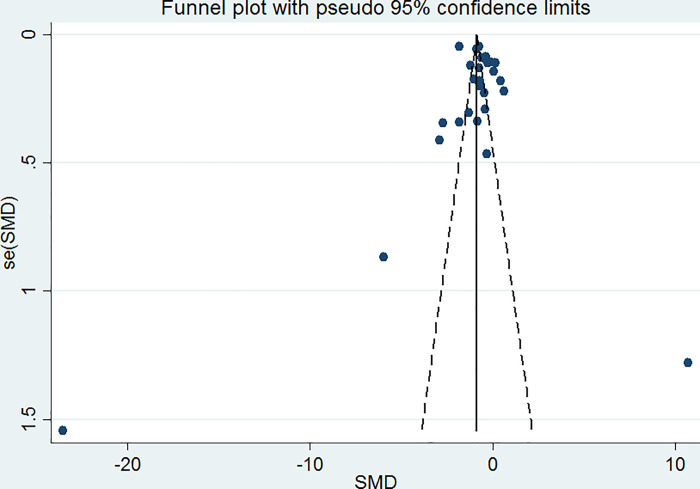
Funnel plot.Funnel plot showing publication bias among the included studies.